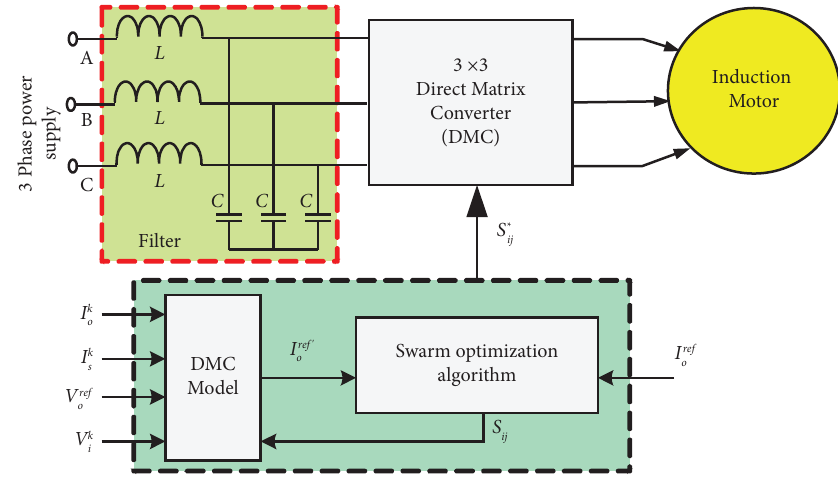
Figure 4: Swam optimization controllers for direct matrix converters.